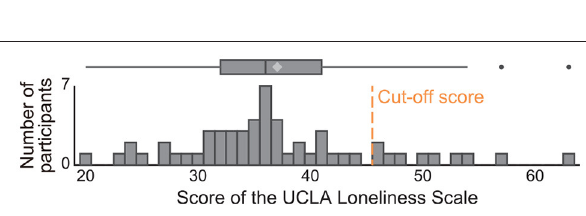
and root mean square error (RMSE). MAE and RMSE were